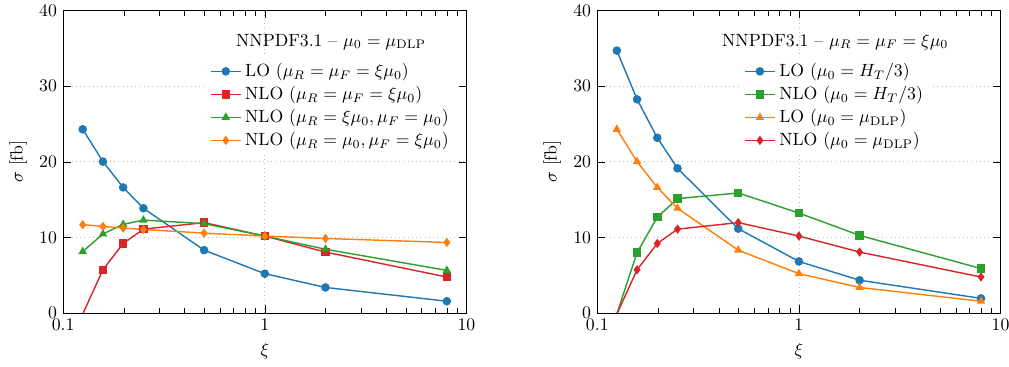
Figure 12 . Scale dependence of the LO and NLO integrated fiducial cross sections for the pp → √ e + ν e µ − ¯ ν µ b ¯ b b ¯ b + X production process at the LHC with s = 13 TeV for µ 0 = µ DLP . The LO and NLO NNPDF3.1 PDF sets are employed. Also shown is the variation of µ R with fixed µ F and the variation of µ F with fixed µ R as well as the comparison to our default scale choice µ 0 = H T / 3